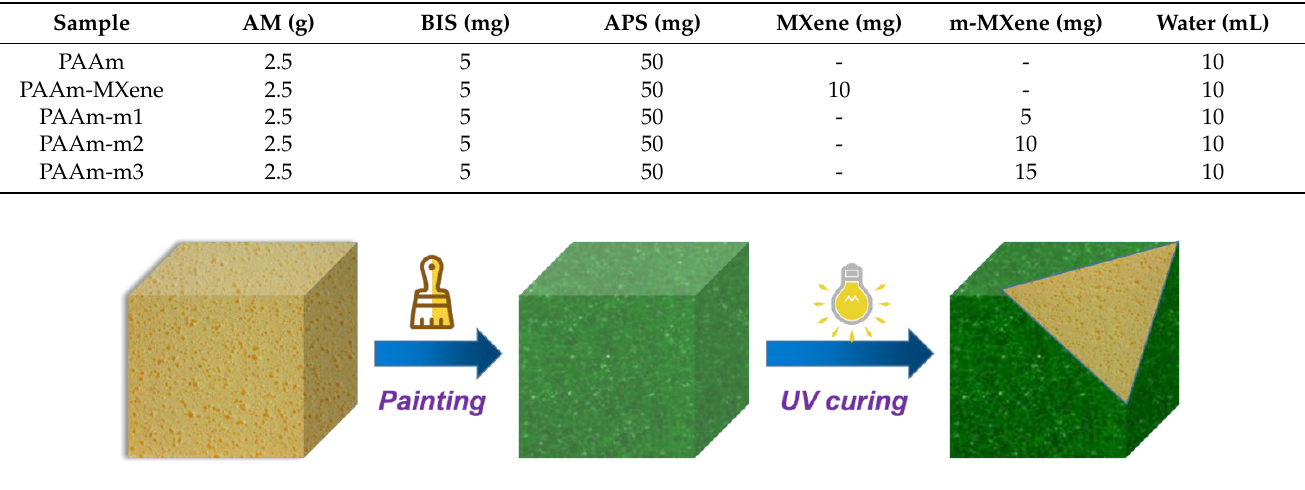
Figure 12. Preparation process of Coated RPUF.